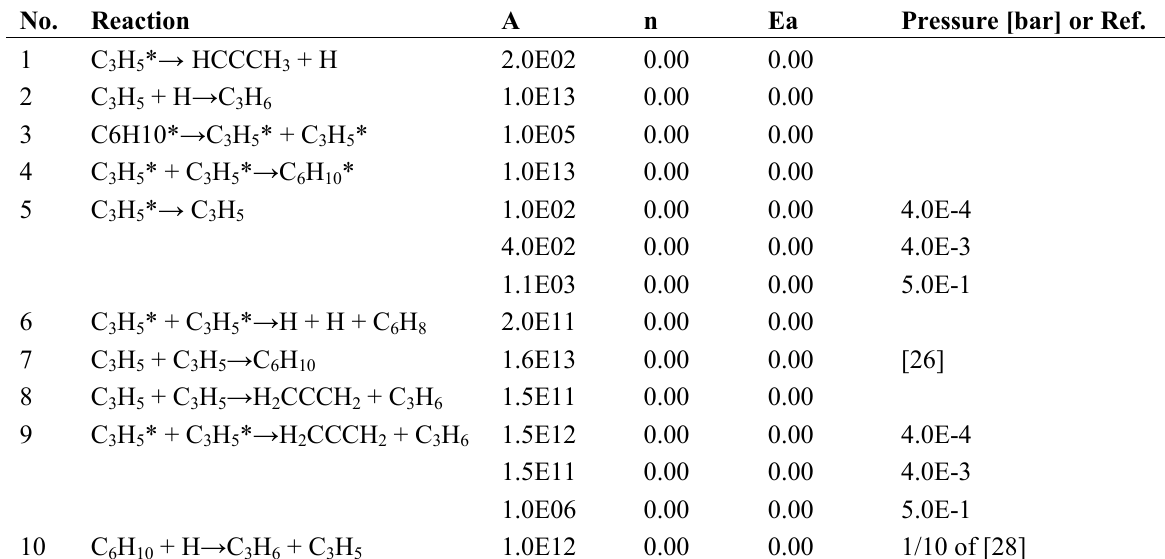
Table 2. Kinetic model for the simulation of pressure dependent end product yields, which are shown in Figure 3. Rate constant units are mol/cm 3 s for bimolecular and s − 1 for H represents 1,5-hexadiene. * indicates reactions of chemically unimolecular reactions. C 6 10 activated species. For some reactions pressure dependent rate coefficients are derived by logarithmic pressure interpolation between the given pressure